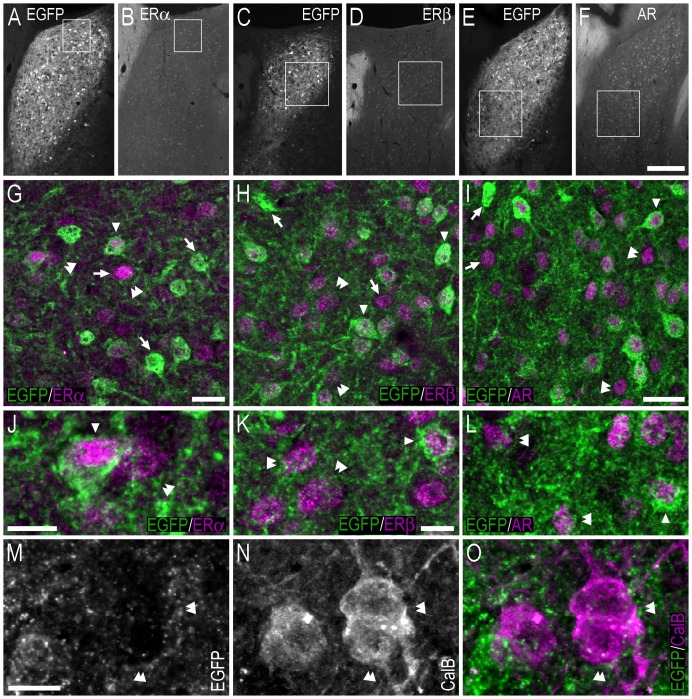
Double-immunofluorescence photo and confocal micrographs showing the distribution of EGFP-, ERα−, ERβ-, AR- and calbindin-LI in the bed nucleus of the stria terminalis.(A, B) Single-channel photomicrographs of double-fluorescence immunohistochemistry, showing EGFP− (A) and ERα-LI (B) (Bregma, −0.22 mm). (C, D) Single-channel photomicrographs of double-fluorescence immunohistochemistry, showing EGFP− (C) and ERβ-LI (D) (Bregma, −0.34 mm). (E, F) Single-channel photomicrographs of double-fluorescence immunohistochemistry, showing EGFP− (E) and AR-LI (F) (Bregma, −0.10 mm). (G–I) Confocal micrographs of double-immunofluorescence histochemistry displaying (G) EGFP− (green) and ERα-LI (magenta), (H) EGFP− (green), and ERβ-LI (magenta), and (I) EGFP− (green) and AR-LI (magenta). Confocal micrographs in (G), (H) and (I) are magnified views of the white squares shown in (A, B), (C, D) and (E, F), respectively. (J–L) Confocal micrographs of double-immunofluorescence histochemistry displaying (J) EGFP− (green) and ERα-LI (magenta), (K) EGFP− (green), and ERβ-LI (magenta), and (L) EGFP− (green) and AR-LI (magenta). The confocal micrographs in (J, K, L) are magnified views of the immunohistochemistry presented in (G, H, I), respectively. (M–O) Single-channel confocal micrographs of double-fluorescence immunohistochemistry (O), displaying EGFP− (M), and calbindin-LI (N). In G–L and M–O, arrows point to single labelled cell bodies, arrowheads point to double-labelled cell bodies, and double arrowheads point to apparent contacts or close anatomical association between EGFP-ir nerve fibres and single-labelled ERα− (G, J), ERβ- (H, K), AR- (I, L) or calbindin-ir (O) cell bodies. Scale bars: F = 200 µm, applies A–F; G = 20 µm; I = 25 µm, applies H, I; J = 10 µm; K = 10 µm, applies K, L; M = 10 µm, applies M–O.